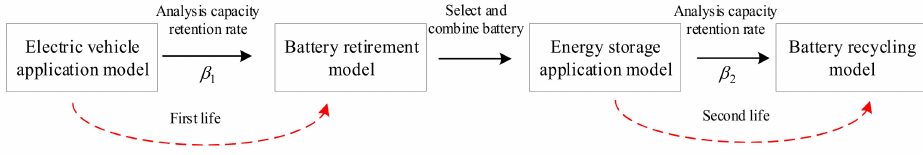
Figure 2. The two life stages of electric vehicles power